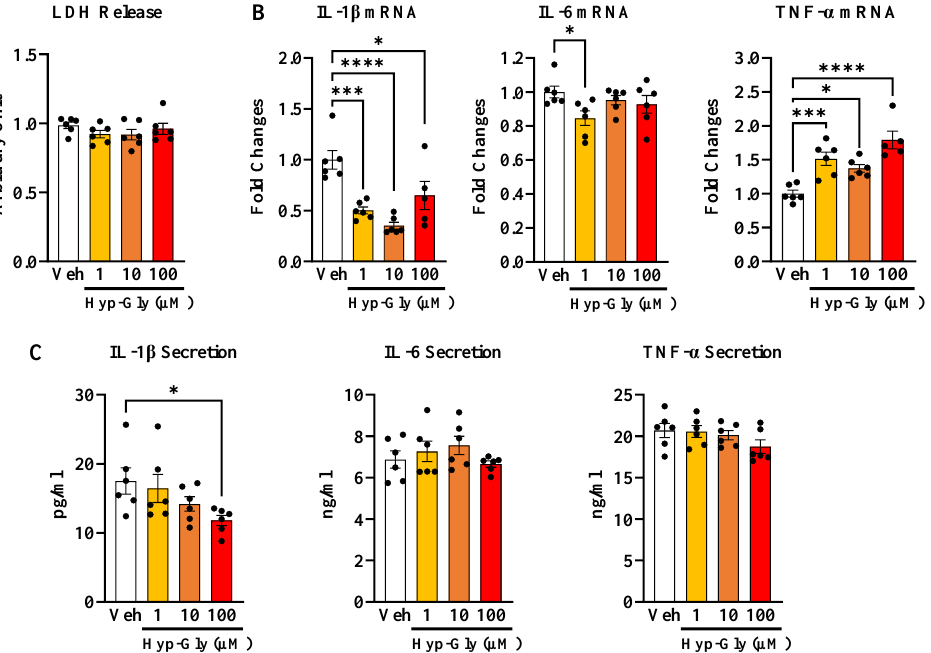
Figure 1. The concentration-dependent effect of Hyp-Gly on M1 macrophage ( A ) LDH release ( n = 6), ( B ) inflammatory cytokine gene expression ( n = 5–6), and ( C ) inflammatory cytokine secretion ( n = 6). Data are shown as means ± SE. Data were analyzed by one-way ANOVA followed by Dunnett’s post hoc test compared to vehicle (Veh) [* p < 0.05, *** p < 0.001, **** p < 0.0001].